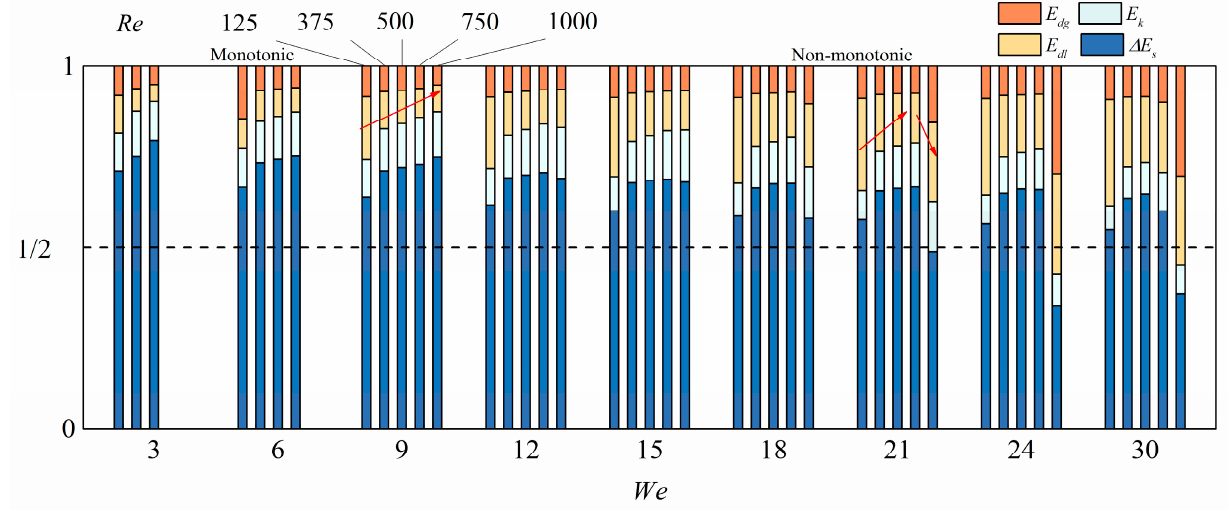
Figure 9. Energy budget under small Weber numbers for different Reynolds numbers.